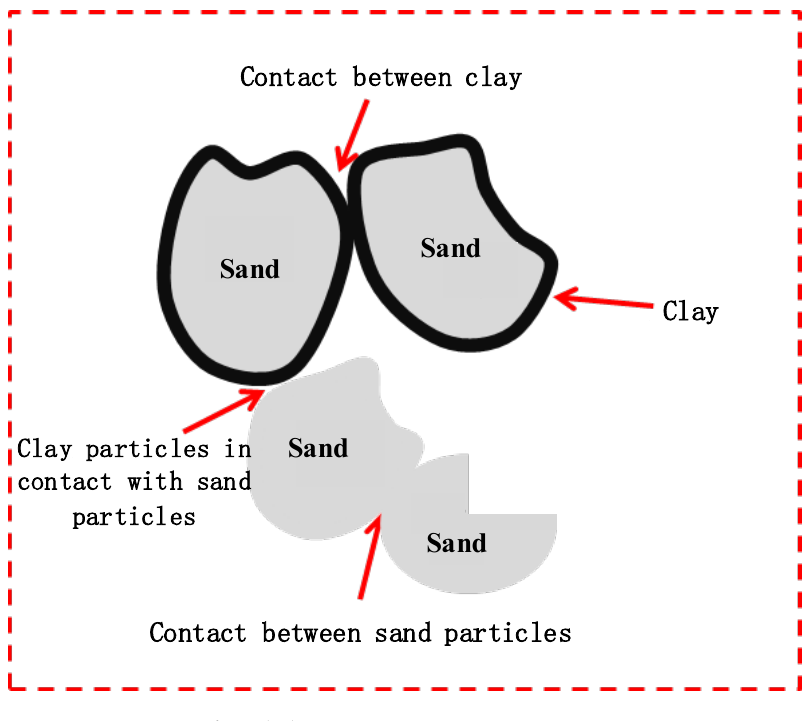
Figure 11. Diagram of sand-clay contact.